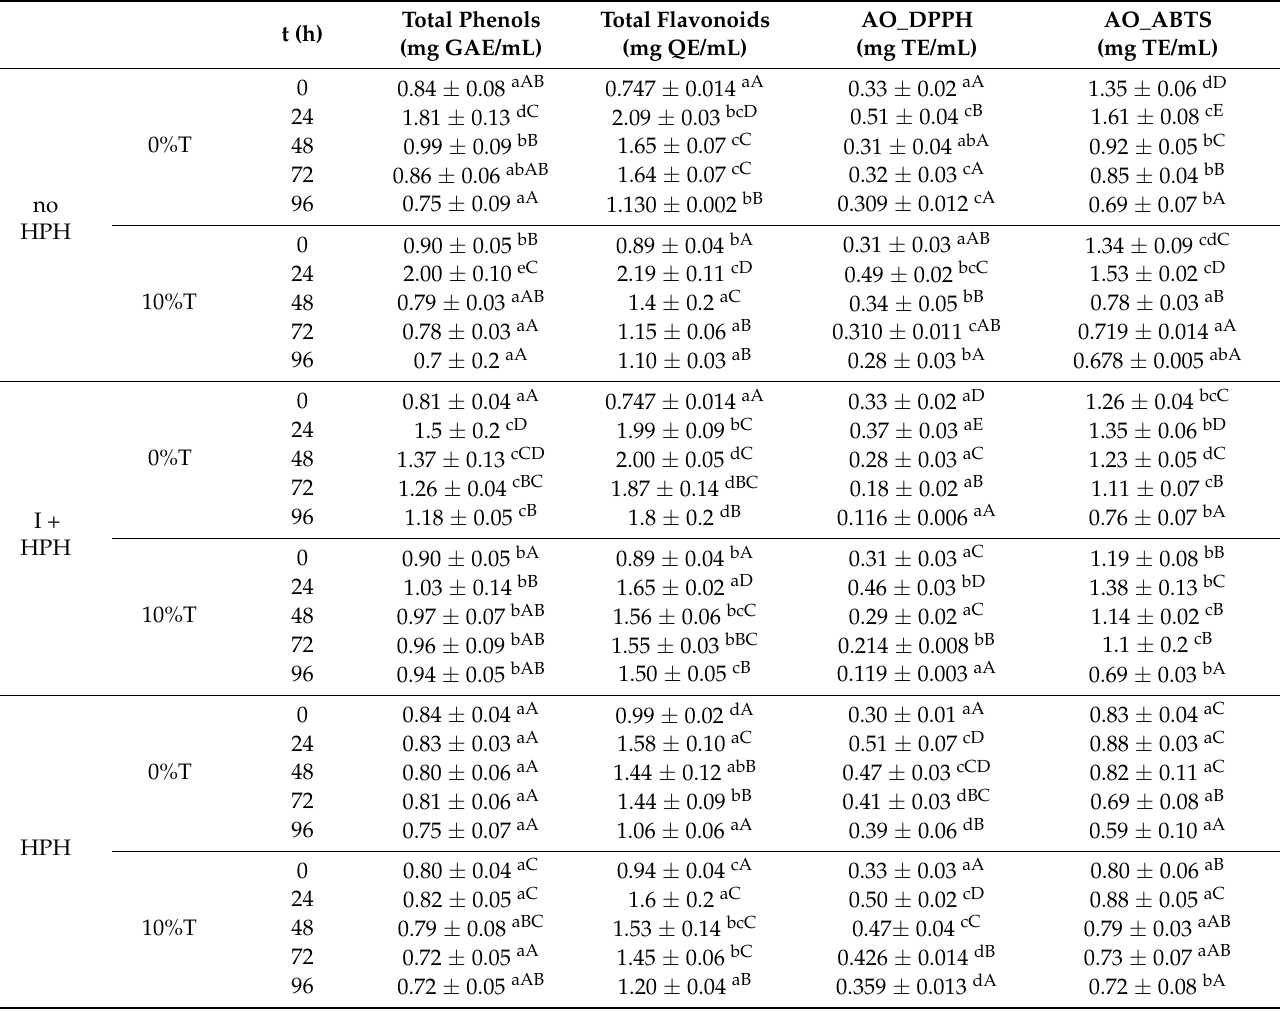
Table 2. Antioxidant properties of clementine juice subjected to different treatments along their fermentation with L. salivarius spp. salivarius CECT 4063 for 4